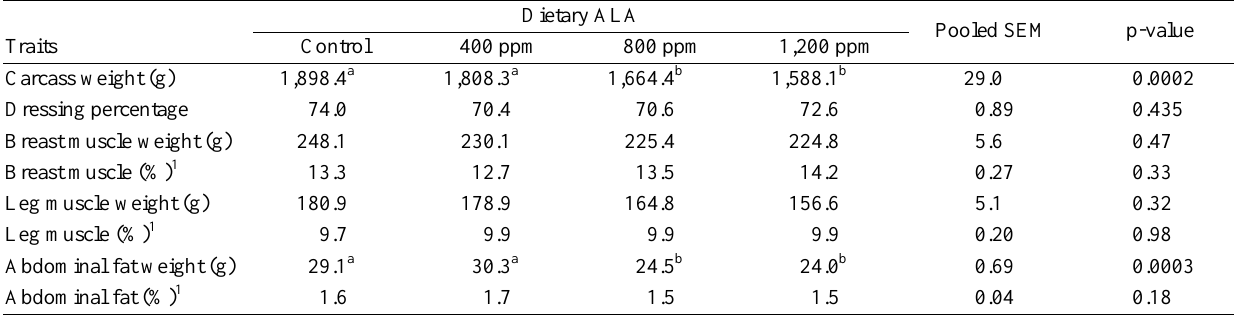
Table 3. Effects of dietary ALA on carcass characteristics of broilers